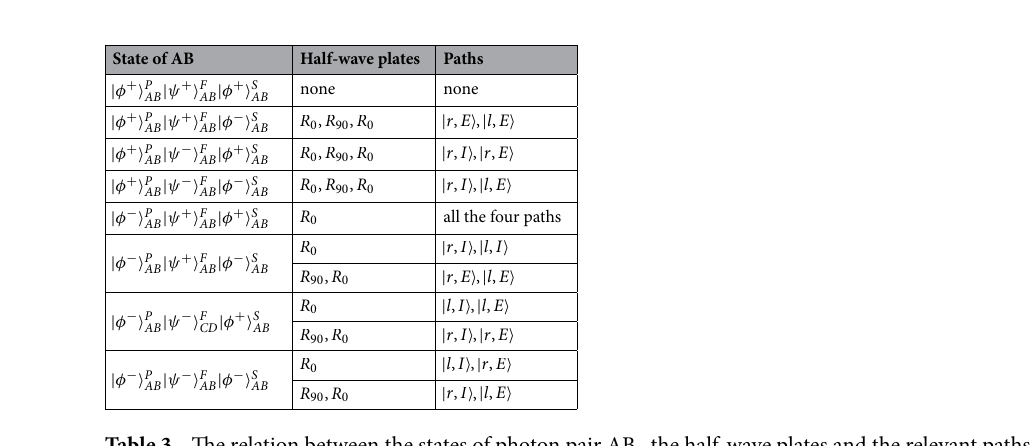
accomplish the phase-flip operations for all the three modes by putting R 0 in the paths r , I l , E the paths and of the photon A, respectively. | � | � In the second case, one of the parity check measurement results is odd-parity result. The four-photon system (cid:31) 2 (cid:31) 3 (cid:31) 4 is projected into the state , or , respectively, with the corresponding probability P | � ABCD | � ABCD | � ABCD 2, 3, 4 ). We take the state (cid:31) 2 ( i as an example. Here = | � ABCD